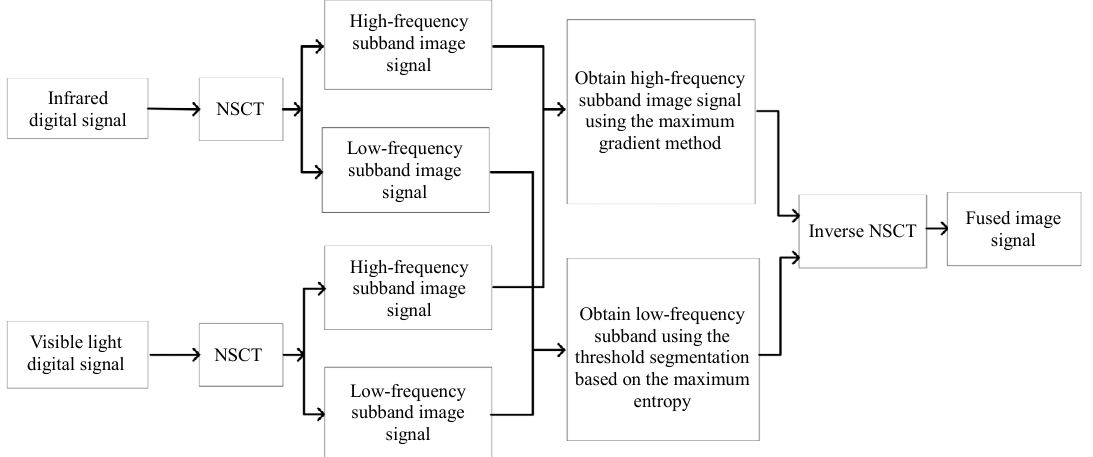
Fig. 3 Overall block diagram of the signal fusion